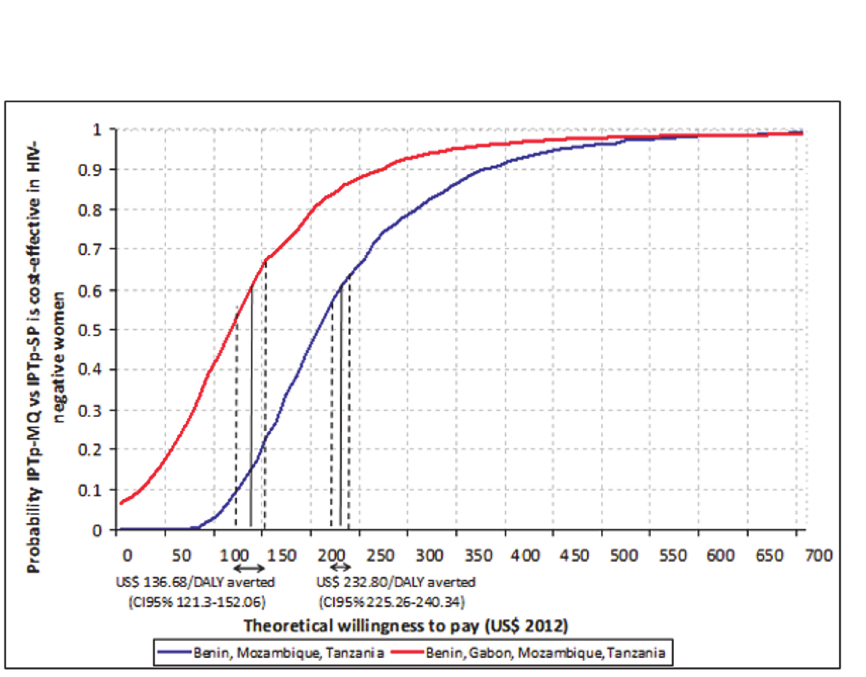
Fig 5. Cost-effectiveness of IPTp-MQ versus IPTp-SP in HIV-negative pregnant women in Benin, Gabon, Mozambique and Tanzania: acceptability curves. IPTp-MQ = Intermittent Preventive Treatment of malaria in pregnancy with Mefloquine; IPTp-SP = Intermittent Preventive Treatment of malaria in pregnancy with Sulphadoxine-Phyrimethamine; HIV = Human Immunodeficiency Virus; DALYs = Disability-adjusted life years. Acceptability curves were constructed by plotting the cumulative distribution of the incremental cost- effectiveness ratios (ICERs) of IPTp-MQ compared with IPTp-SP per DALYs averted. The Y axis is interpreted as probability that the intervention is cost-effective for every level of policy makers ’ willingness to pay for each DALY averted (X axis). US$ 136.30 per DALY averted (CI95% 131.41 – 141.18) is the ICER for the scenario including Benin, Gabon, Mozambique and Tanzania. US$ 237.99 (CI95% 230.99 – 244.57) per DALY averted is the ICER for the scenario excluding